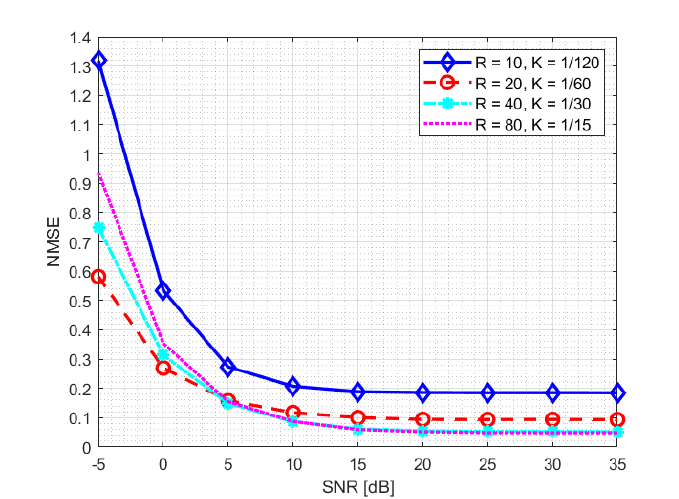
Figure 6. NMSE statistics for NR-CsiNet model trained at SNR = 10 dB.